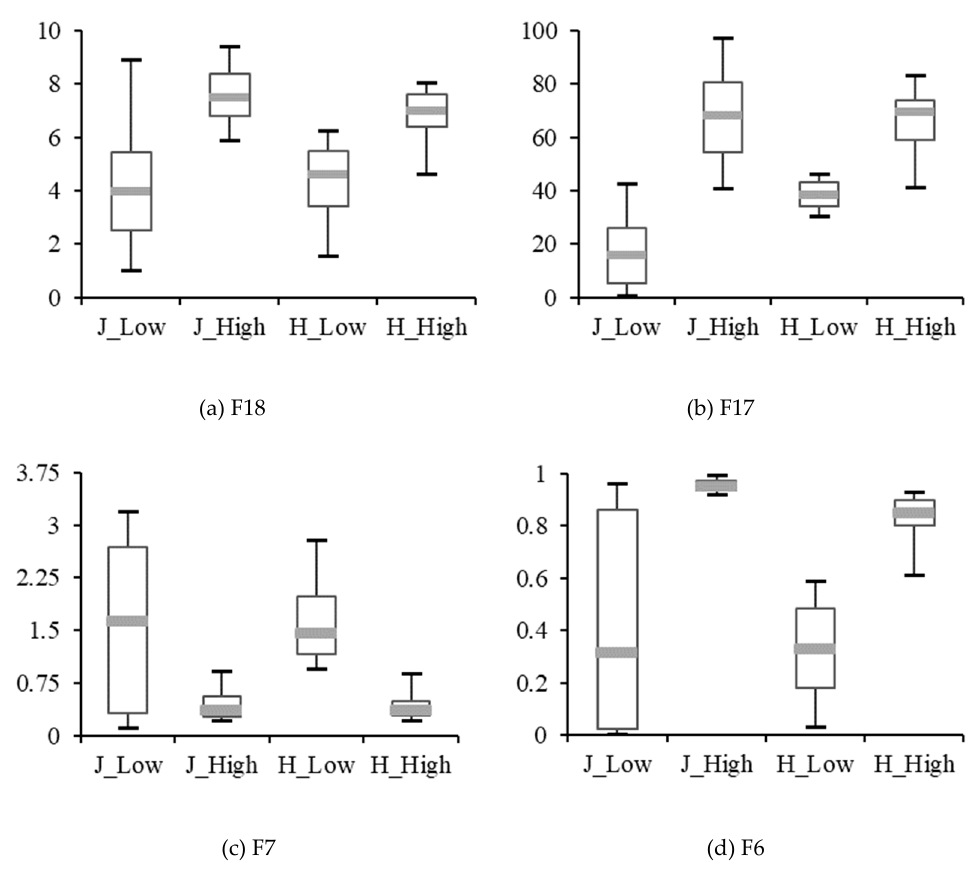
Figure 6. Boxplots of ( a ) F18, ( b ) F17, ( c ) F7, and ( d ) F6 of Jiangxia and Huangpi with lower and higher PI. The low PI of Jiangxia, high PI of Jiangxia, low PI of Huangpi, and high PI of Huangpi are represented as J_Low, J_High, H_Low, and H_High, respectively.